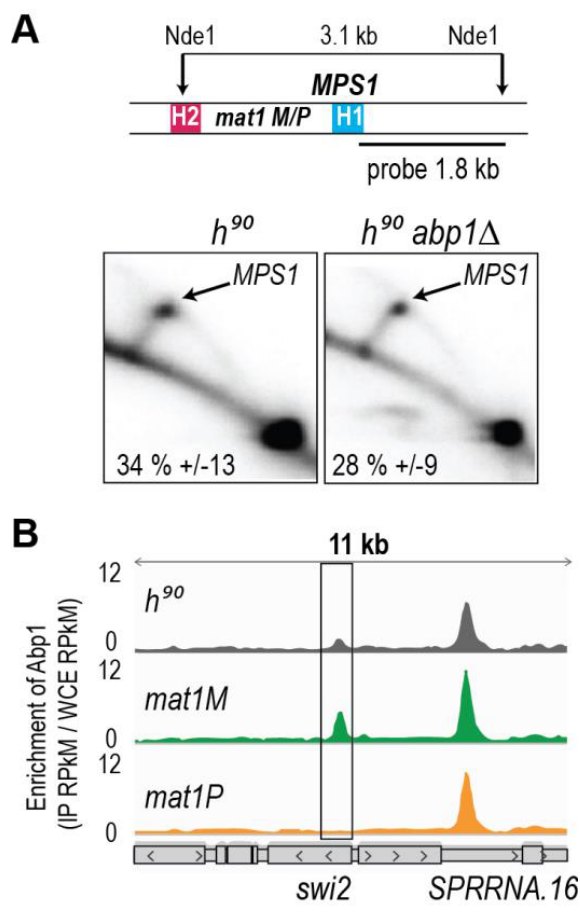
FIGURE 2: Abp1 does not control MPS1 but is recruited at swi2 as a function of the mating type. (A) The upper panel indicates the probe and restriction enzyme used for the analysis of the replication intermediates. The lower panel represents the 2D gel analysis of the MPS1 site at mat1 in h 90 strain and in h 90 abp1∆ strain (n=3). (B) Distribution of normalized enrichments of the Abp1 ChIPs at the swi2 locus (IP RPkM / WCE RPkM) in h 90 (gray), mat1M stable (green) and mat1P stable (orange). Gray boxes indicate the genes in the region and arrows the transcription direction. Loci where Abp1 is enriched are